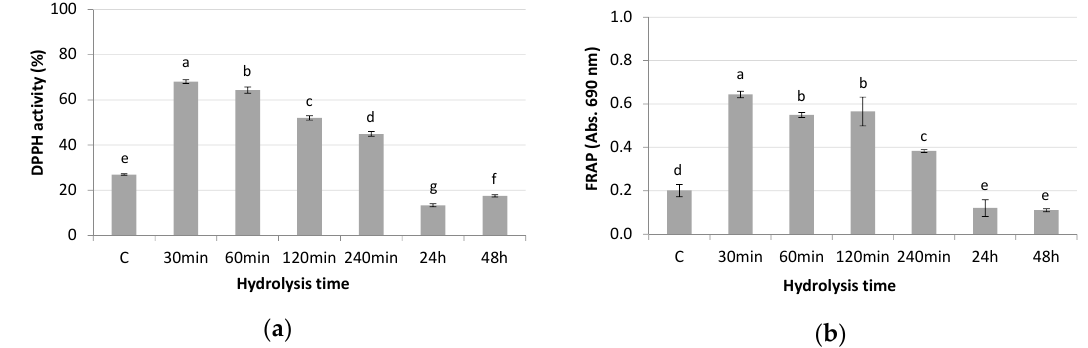
Figure 1. Antioxidant activity determined by ( a ) DPPH radical scavenging activity and ( b ) ferric reducing antioxidant power (FRAP) of tomato by-products hydrolysates obtained at different Alcalase hydrolysis times. a-g: different letters indicate significant differences between hydrolysis times ( p < 0.05).